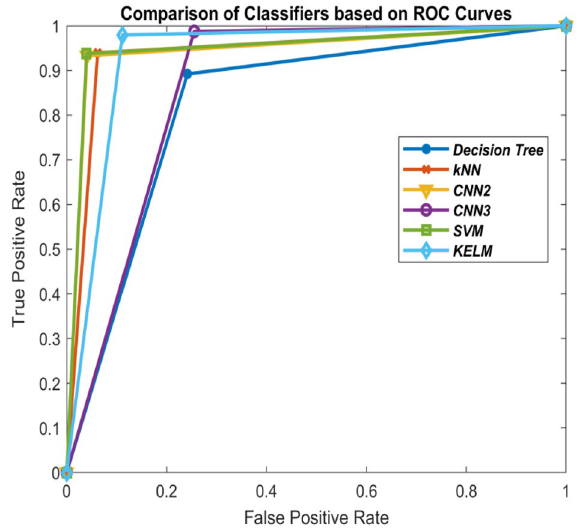
Figure 11. Comparison of the classifiers based on ROC curves (30–70 train-test ratio) of CoViD19+ve and CoViD19−ve.